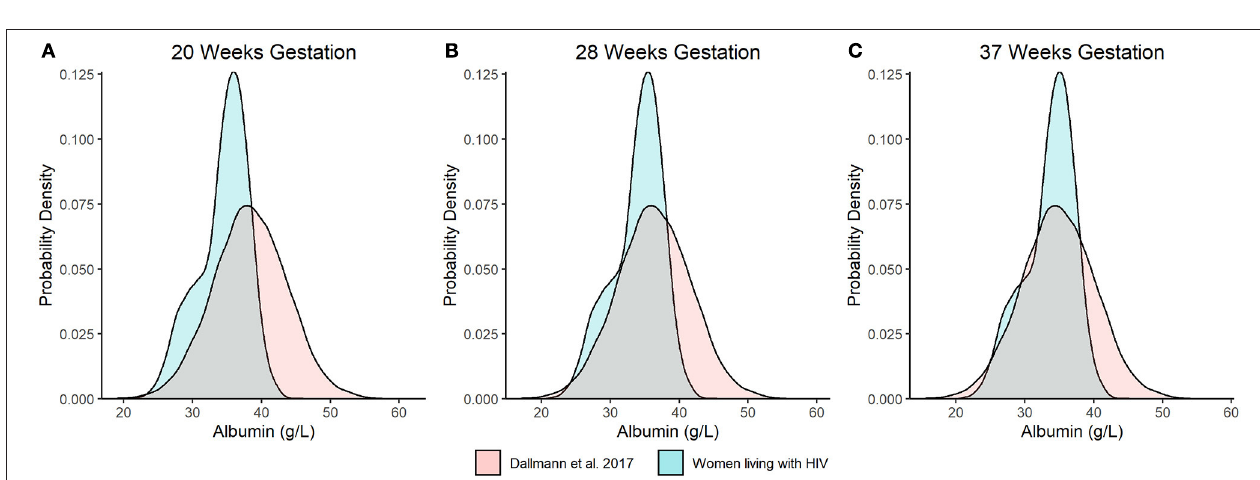
FIGURE 3 | Distributional comparison of predicted serum albumin concentration values at (A) 20, (B) 28, and (C) 37 wks gestation between our model and Dallmann et al.’s published equation (8). Distributions of serum albumin concentrations were generated over 10,000 stochastic simulations from each respective model/equation.